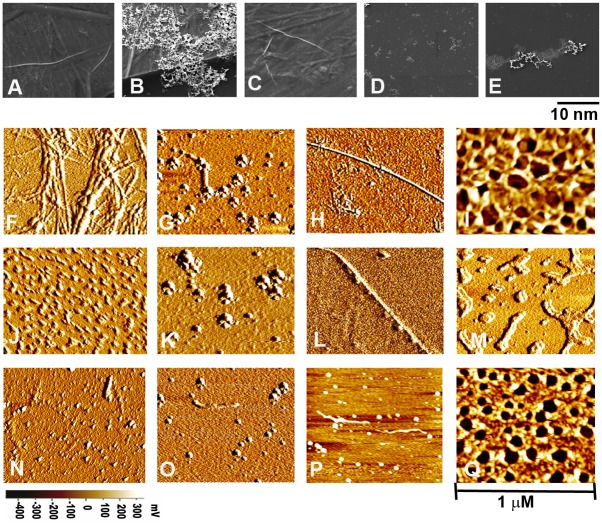
Effect of plant enzyme on morphology of Aβ42 aggregates and fibrin-Aβ42 co-aggregate.
(A) Aβ42 (20 μM) fibrillar form obtained after incubation of Aβ42 peptide (100 μM DMSO solution) in 10 mM sodium phosphate, pH 7.5, containing 100mM NaCl at 37°C with mild shaking for 7 days; (B) fibrin-Aβ42 co-aggregate showing denser and heavily cross-linked structure; (C) preformed Aβ42 aggregate (20 μM) after incubation for 24 hr in presence of the plant enzyme showing presence of intact fibrils; (D) preformed co-aggregate after incubation for 24 hr in presence of the plant enzyme showing complete degradation of the structure leading to monomeric and very small oligomeric forms; (E) preformed co-aggregate incubated for 24 hr in presence of plasmin showing fragmented residual structures that are large, compact and cross-linked. The resolution and magnification 10 nm and 30,000X respectively. (F) fibrin network; (G) Aβ42 oligomer (20 μM) obtained after incubation of Aβ42 peptide (100 μM DMSO solution) in 10 mM sodium phosphate, pH 7.5, containing 100mM NaCl at 37°C with mild shaking for 24 hr (H) Aβ42 aggregate (20 μM); (I) fibrin-Aβ42 co-aggregate; (J) fibrin treated with plant enzyme showing smaller globular fragments; (K) Aβ42 oligomer treated with plant enzyme showing presence of oligomeric forms; (L) Aβ42 aggregate after incubation for 24 hr in presence of the plant enzyme retain its fibriliar structure; (M) the co-aggregate treated with plant enzyme showing random fragmentation of the fibrillar structure, (N) Fibrin treated with plasmin; (O) Aβ42 oligomer treated with plasmin showing smaller monomeric forms; (P) Aβ42 aggregate treated with plasmin for 24 hr showing few fragments along with small monomers; (Q) co-aggregate pretreated with plasmin showing partial trimming of the structures maintaining thick fibrillar network. The horizontal bar shows the amplitude (mV) of the images. The scan size was 1 μm.